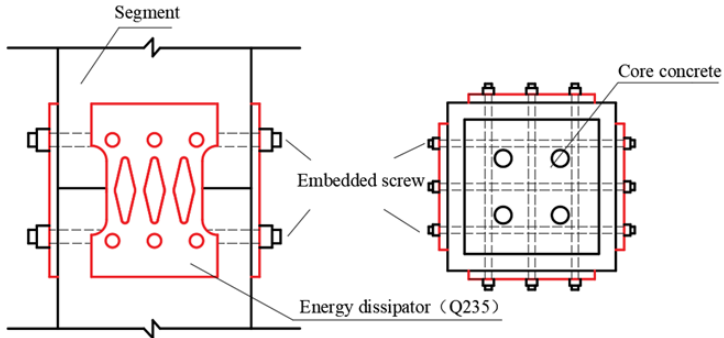
Figure 1. Connection structure of energy dissipation elements.